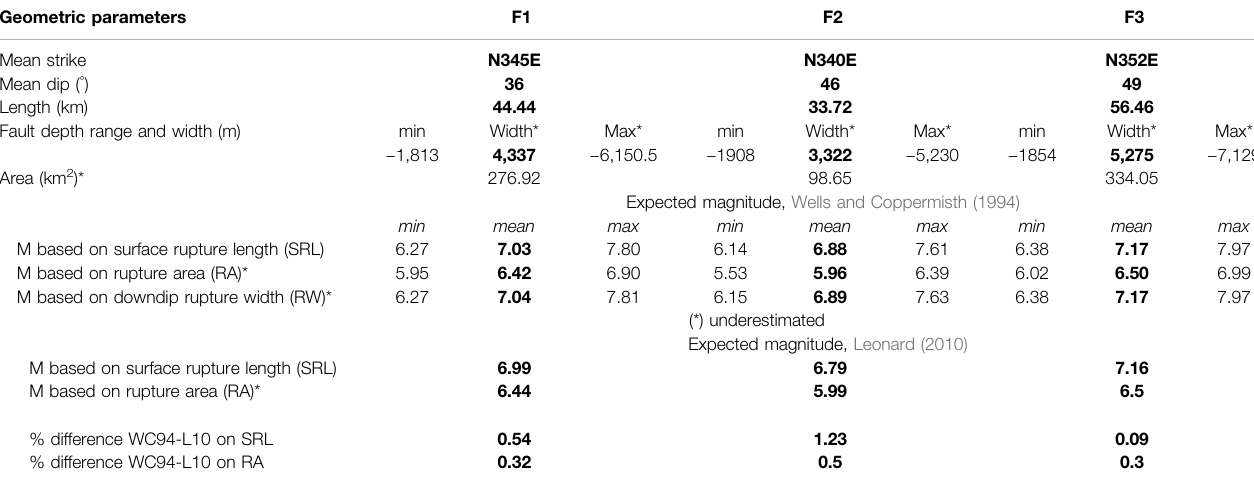
TABLE 1 | Geometric parameters derived from the 2½D data modeling and expected magnitudes from empirical-scaling relationships (Wells and Coppersmith, 1994; Leonard,2010).Notethat,accordingtofaultsegmentationinferredfromthefaultdisplacementanalysis(see FaultDisplacementAnalysisandDeformationRate ),seismic potential for F1 and F2 faults may be